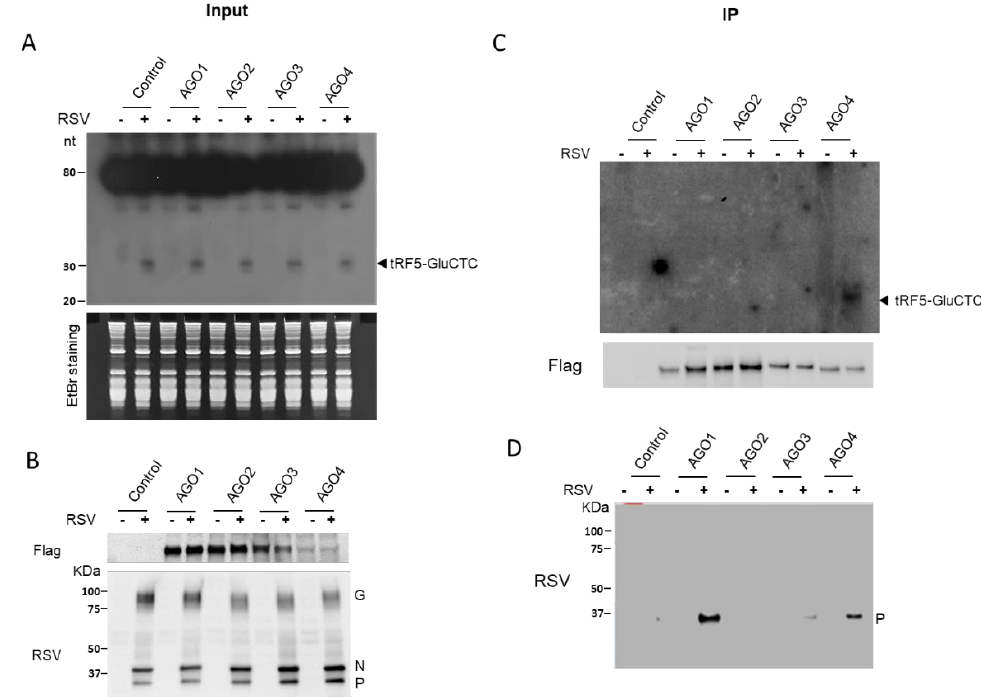
Figure 2. AGO4 interacts with tRF5-GluCTC. ( A ) 293 cells expressing Flag-tagged AGO1, 2, 3, or 4 protein were mock-infected or infected with RSV, at MOI of 1, and total RNA was prepared, followed by Northern hybridization using the tRF5-GluCTC probe to detect the induction of tRF5-GluCTC by RSV infection. EtBr staining is shown for equal loading. EtBr, ethidium bromide. ( B ) Sample input was investigated by Western blot using either an anti-Flag antibody (AGO expression) or an anti-RSV antibody (viral protein expression). ( C ) Total lysates were prepared and followed by IP using an anti-Flag antibody. Flag-AGO bound RNA was purified and subjected to Northern blot for tRF5-GluCTC detection. The AGO expression in the pulldown complex was also investigated by Western blot to ensure the proper IP process. ( D ) To study the association of viral protein(s) with AGO complex, the membrane used in C was stripped and reprobed with an anti-RSV antibody. Data are representative of three independent experiments.